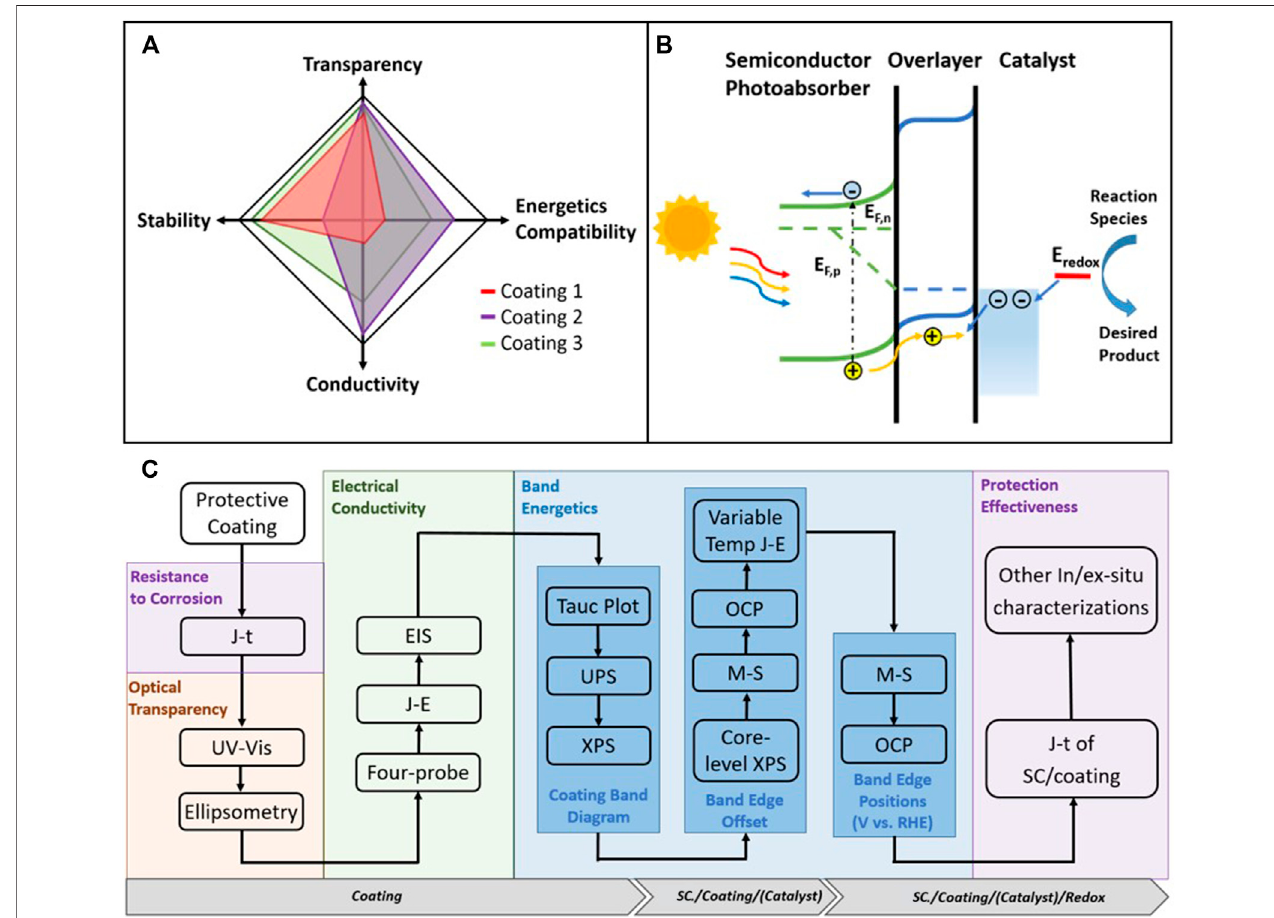
FIGURE 1 | (A) Illustration of the four performance metrics for evaluating protective coatings for PEC water-splitting devices. The performance metrics for three representative coatings are also shown. They include: stability (primarily lifetime/hours), optical transparency (primarily transmittance/%), conductivity (primarily resistance/ohm)andenergeticscompatibility(primarilychargetransferef fi ciencyacrossinterface/%); (B) Schematicsforshowingtheconceptofenergeticscompatibility (here, the photoanode case is used as an example); (C) Flow chart that summarizes the recommended testing protocols for quantitatively evaluating the four performance metrics of a protective coating. Abbreviations: current-time (J-t), current-potential (J – E), electrochemical impedance spectroscopy (EIS), ultraviolet photoelectron spectroscopy (UPS), X-ray photoelectron spectroscopy (XPS), Mott-Schottky (M – S), and open-circuit potential (OCP). SC stands for semiconductor.